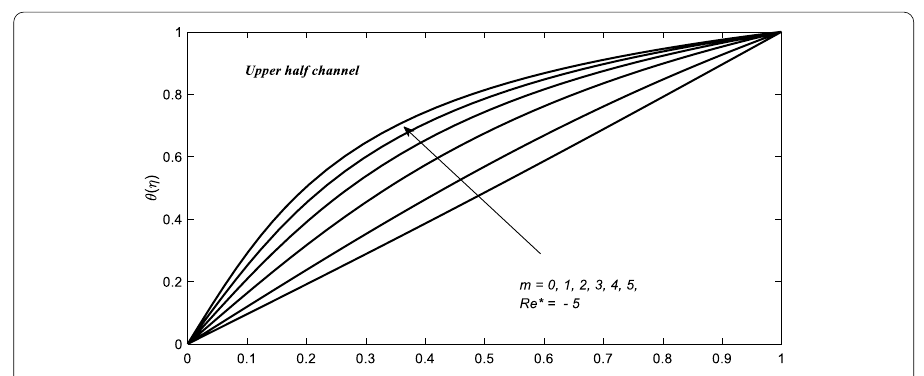
0 : 1, Re* 5 and Pr 1 = = − =